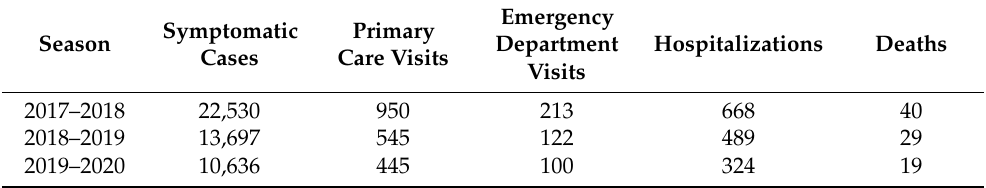
Table 1. Rates of different clinical events per 100,000 population aged 65+. Emergency Symptomatic Primary Season Department Hospitalizations Cases Care Visits Visits